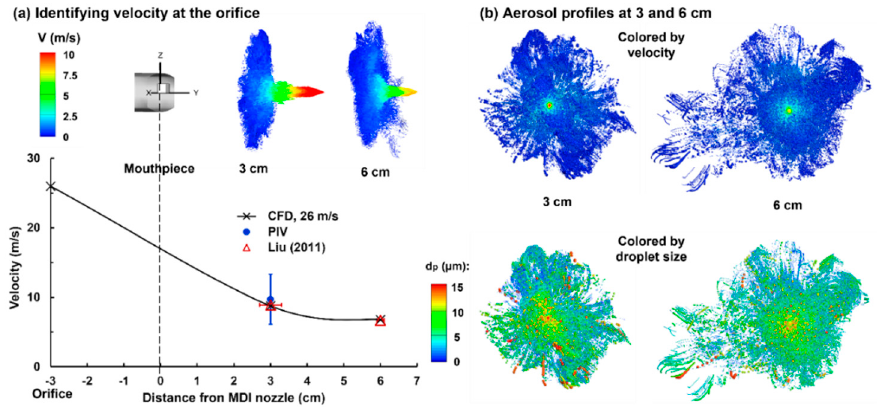
Figure 5. Reverse identification of the discharge velocity at the MDI orifice in comparison to experimental measurements: ( a ) identifying the velocity at the orifice using LES predictions and ( b ) predicted aerosol profiles at 3 and 6 cm from the mouthpiece.